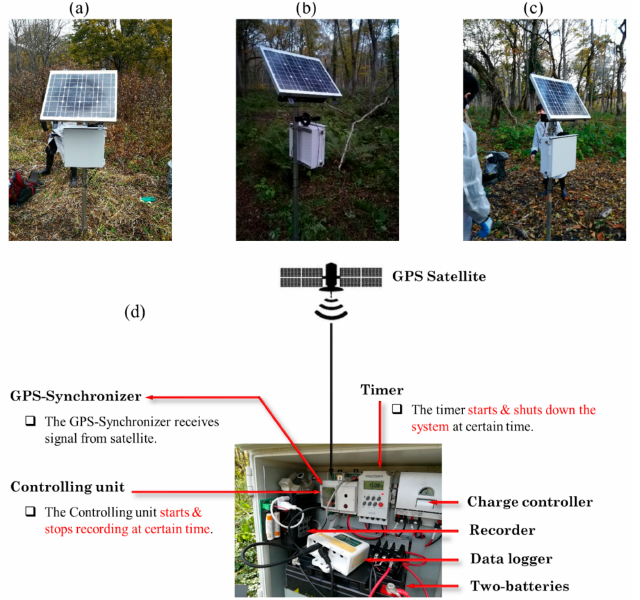
Figure 4. Three sound recorders and solar panels in Oze marshland. ( a ) Recorder 1 (Rec 1), ( b ) Recorder 2 (Rec 2), ( c ) Recorder 3 (Rec 3), and ( d ) components of the sound recording